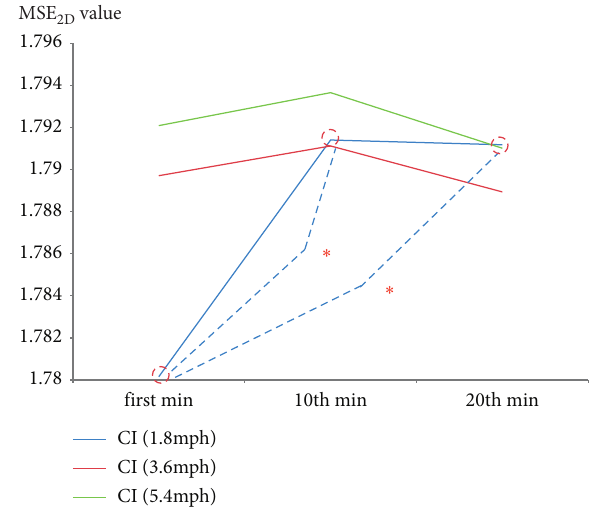
Figure 3: Complexity index (a summation of all time scales of MSE 2D values) of plantar pressure images at the 1 st min, 10 th min, and 20 th min during three walking speeds (1.8, 3.6, and 5.4 mph). ∗ indicates p < 0 .